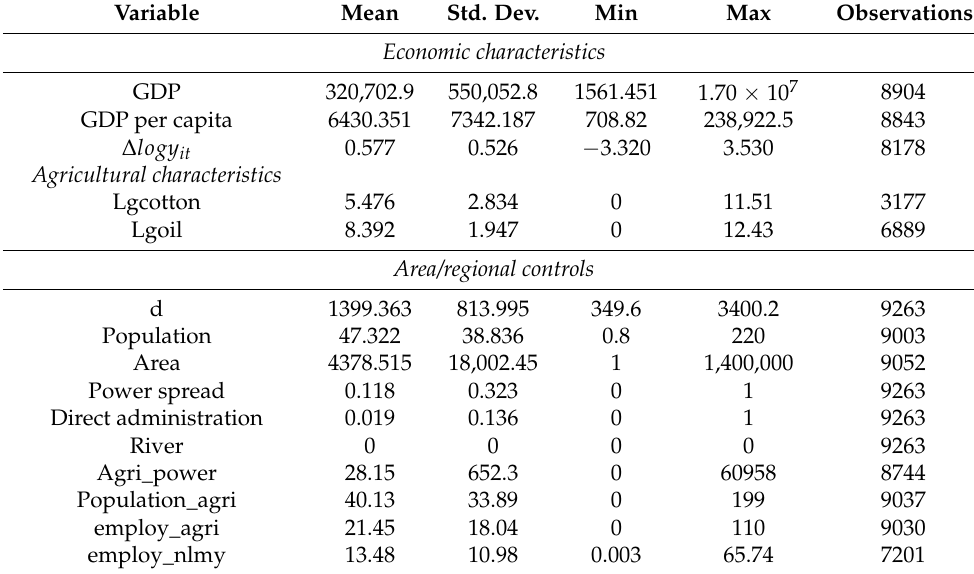
Table 3. Descriptive statistics of the main variables (control